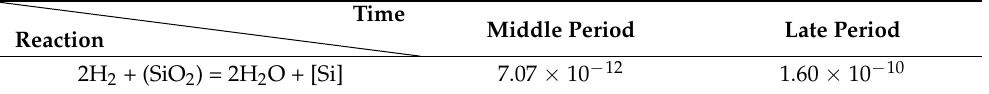
Table 11. Equilibrium partial pressure ratios of water and hydrogen for 2H 2 + (SiO 2 ) = 2H 2 O + [Si]. Reaction